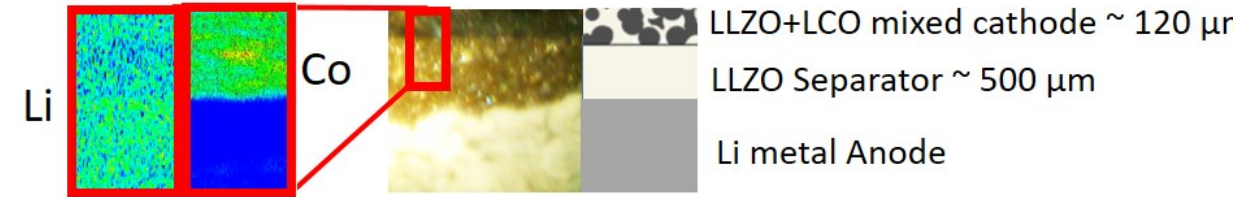
Figure 9. Camera image of the 4.2 V charged LLZO-based cells as seen through the beam window ( centre ) with a schematic of the cell setup ( right ) including approximate thicknesses. The red rectangle marks the analysis region of 50 × 300 µ m 2 and the resulting Co mapping by PIXE and Li mapping by PIGE ( left